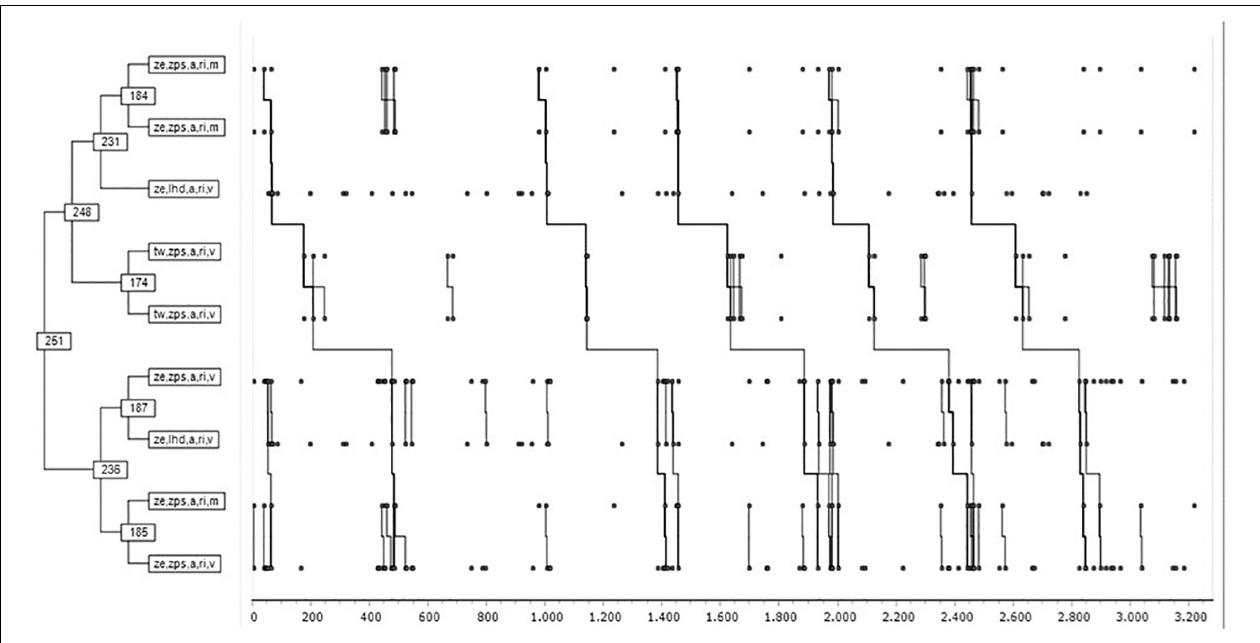
FIGURE 5 | Dendrogram of temporal regularities between Hunters and